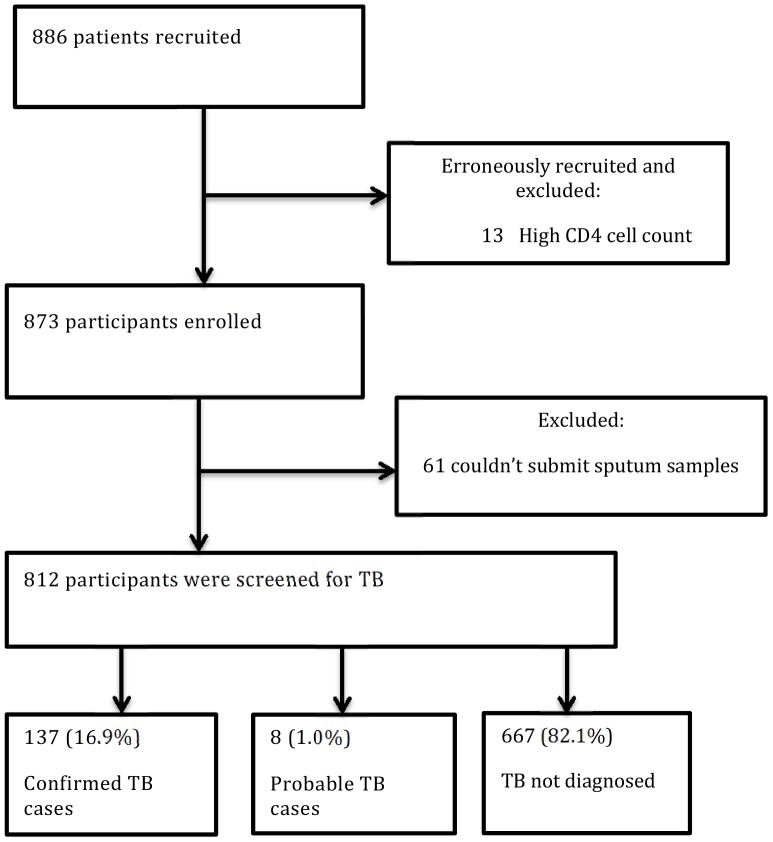
Flow chart of the study participants.